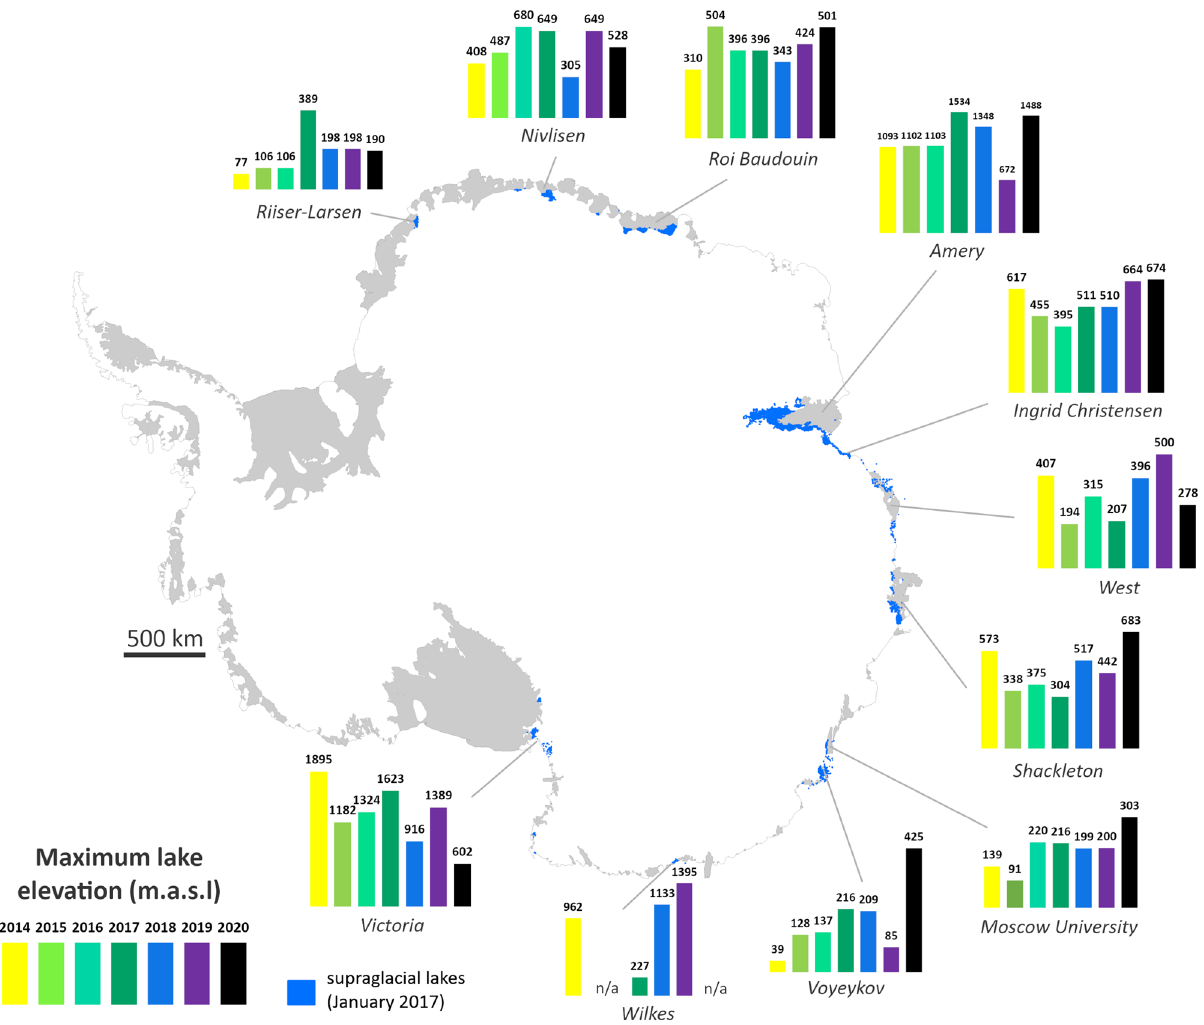
Fig. 4 Maximum elevation of supraglacial lakes in January from 2014 to 2020 around East Antarctica. Key ice shelves/regions are highlighted. Grey areas are ice shelves and fl oating glacier tongues. Grounding line from ref. 77 and coastline from ref. 78 . Lake extents in January 2017, the most extensive lake year, are shown in blue.